Question: Is the quantity shown trending increasing or decreasing?
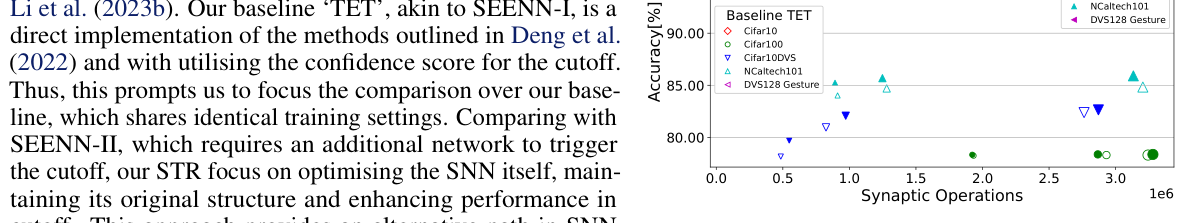
Answer: decreasing